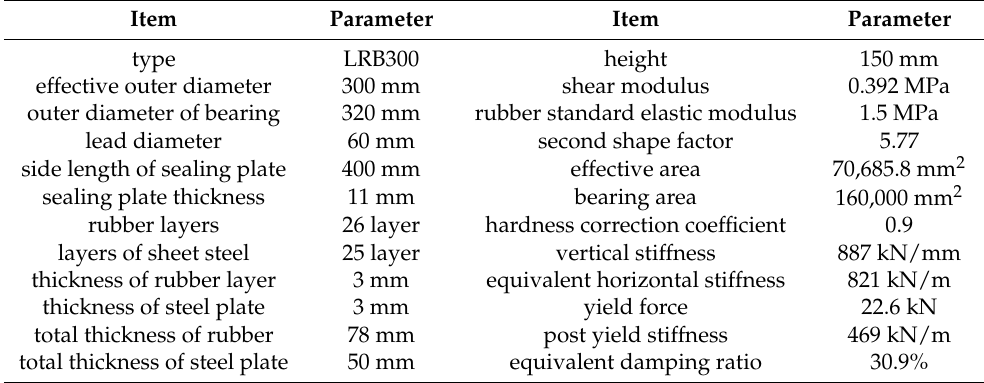
Table 2. Lead-core rubber bearing